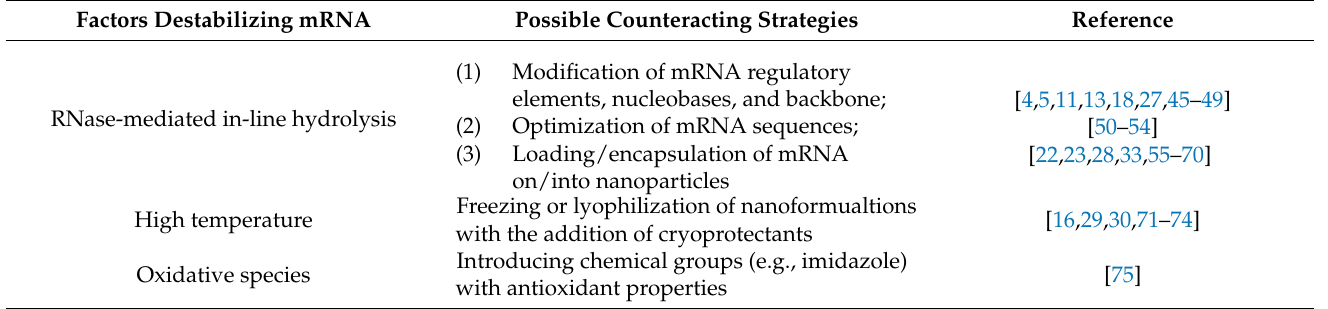
Table 1. Factors leading to mRNA degradation and brief description on their counteracting